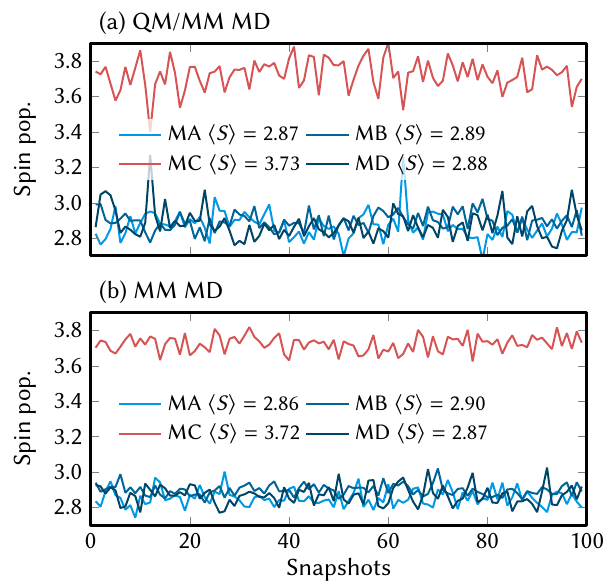
Figure 3. Mulliken spin populations of all Mn atoms in [Mn III Mn IV ( a ) and the MD trajectory ( b ). Here, MC is the Mn III atom. The spin populations were computed at the same level of theory as the reference QM/MM MD